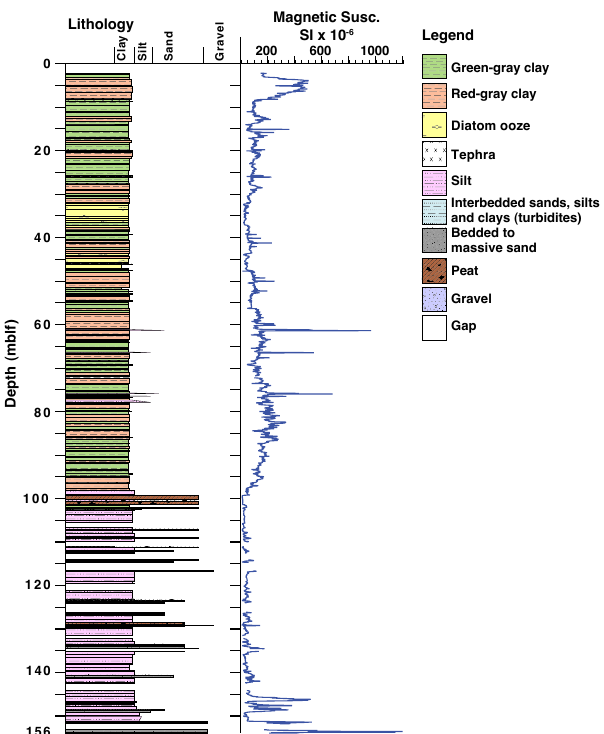
Figure 6. Summary stratigraphy of core TDP-TOW15-1F, based on initial core descriptions. Lithology data are based upon visual and smear slide descriptions, and are rendered in PSICAT. Magnetic susceptibility data measured on the whole (unsplit) core from the Geotek MSCL are shown in the central panel, and at far right is the key to the lithologic symbols. Blank (white) areas indicate zones with no